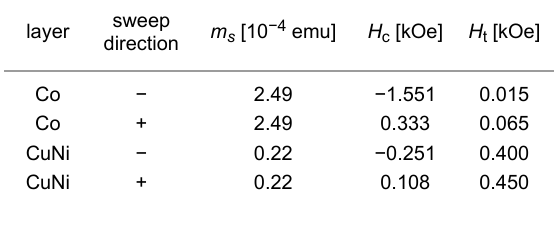
Table 2: Parameters used in modeling the hysteresis loop in Figure 4 according to the simple version of the model of Geiler and co-workers [62]. Here, negative and positive sweep direction refers to the semi- loops, where the applied field was decreased from positive saturation to negative saturation and vice versa, respectively. Moreover, a linear contribution with a slope of s = − 2.98·10 − 6 emu/kOe and an offset of the magnetic moment scale of m 0 = 4.4·10 − 6 emu are considered. For a critical discussion of the used parameters see the